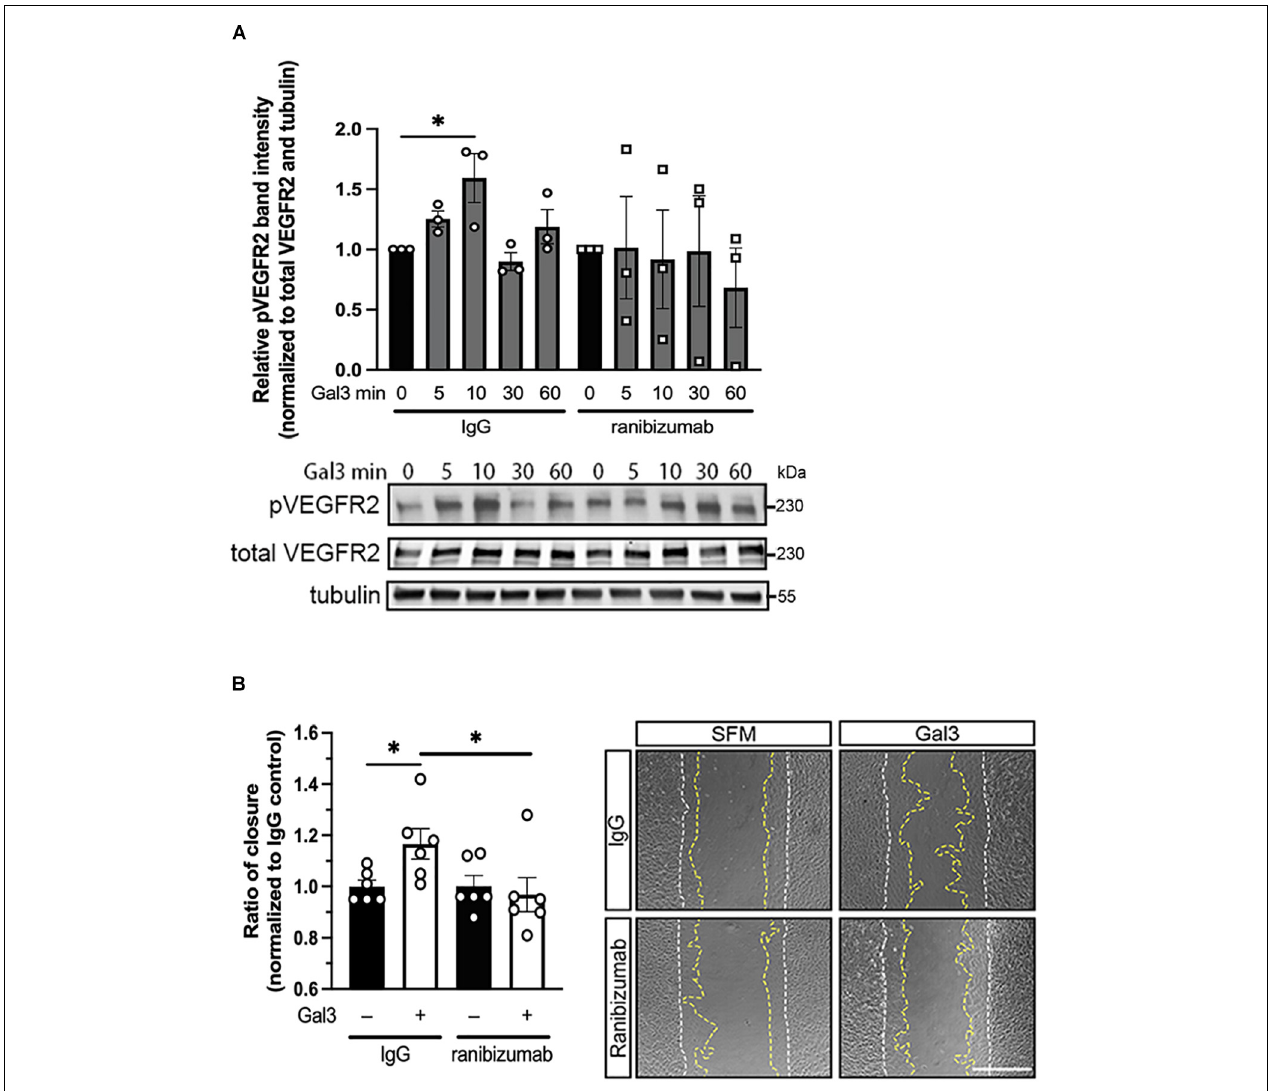
FIGURE 3 | Galectin-3 requires VEGF to induce VEGFR2 activity. (A) Ranibizumab (10 µ g/ml) was added to neutralize endogenous VEGF and HRECs were stimulated with 50 µ g/ml of Gal3 for 0, 5, 10, 30, and 60 min. Cell lysates were collected and pVEGFR2 Y1175 (pR2), VEGFR2 (TR2), and α -tubulin protein levels were analyzed by western blot. Ordinary one-way ANOVA was applied. ∗ P < 0.05, n = 3. (B) Confluent HRECs were scratched and stimulated with 50 µ g/ml of Gal3 with 10 µ g/ml of ranibizumab or control IgG. Images were taken immediately after scratching and at 15 h later. Scale bar represents 500 µ m. Cell migration was quantified using ImageJ. Student T -test was applied, ∗ P < 0.05, n =